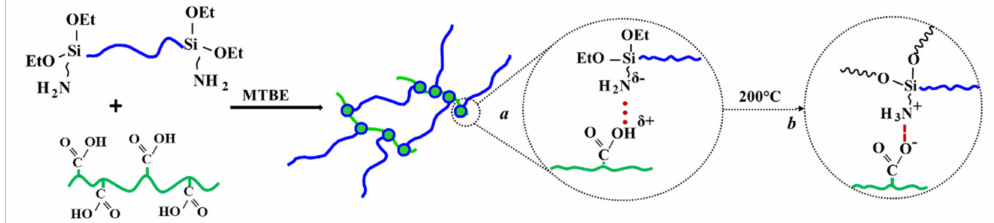
Figure 5. Curing scheme for two-component formulations based on 3-aminopropyl diethoxysilyl-terminated and carboxyl- containing PDMS.